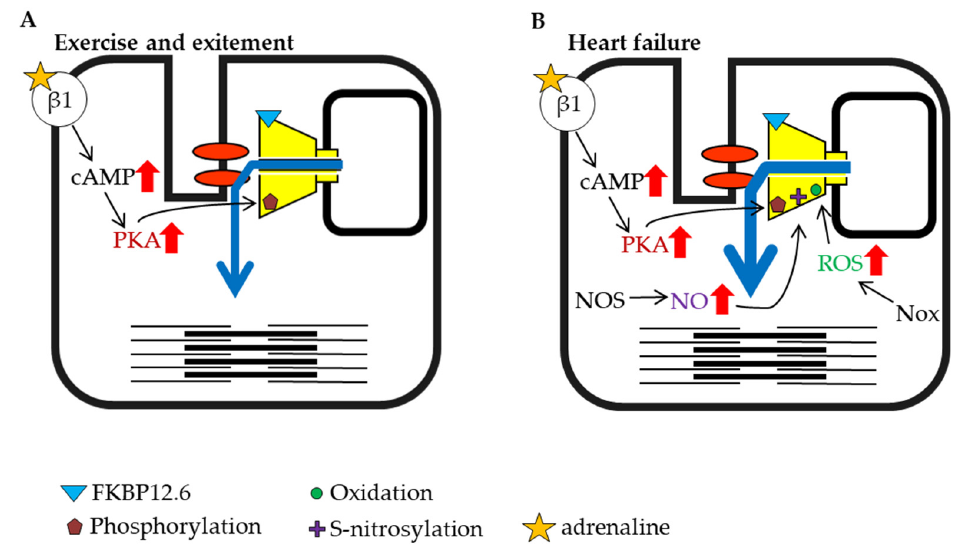
Figure 3. Schematic representation of cardiac ryanodine receptor (RyR2) modulation by intracellular factors under different conditions (part 1). ( A ) Exercise and excitement. ( B ) Heart failure.